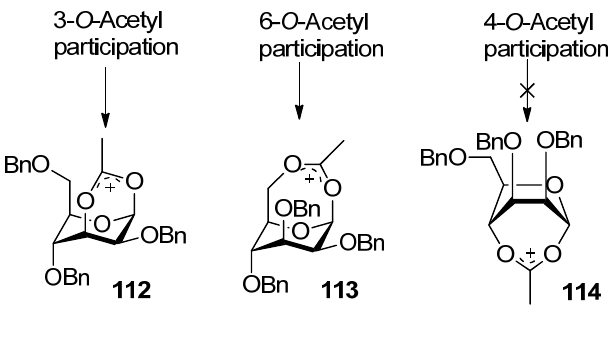
Figure 2. Dioxocarbenium ion intermediates by remote